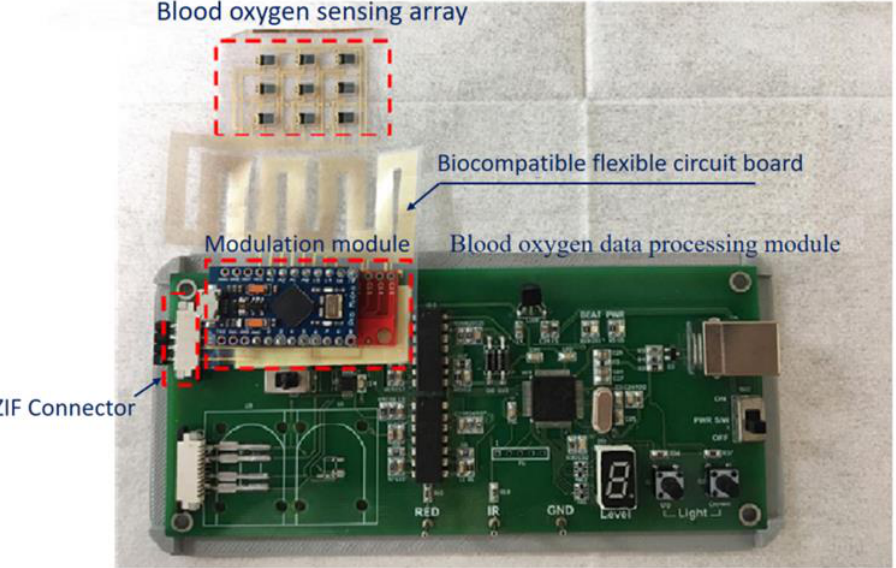
Figure 7. The actual blood oxygen sensing system.